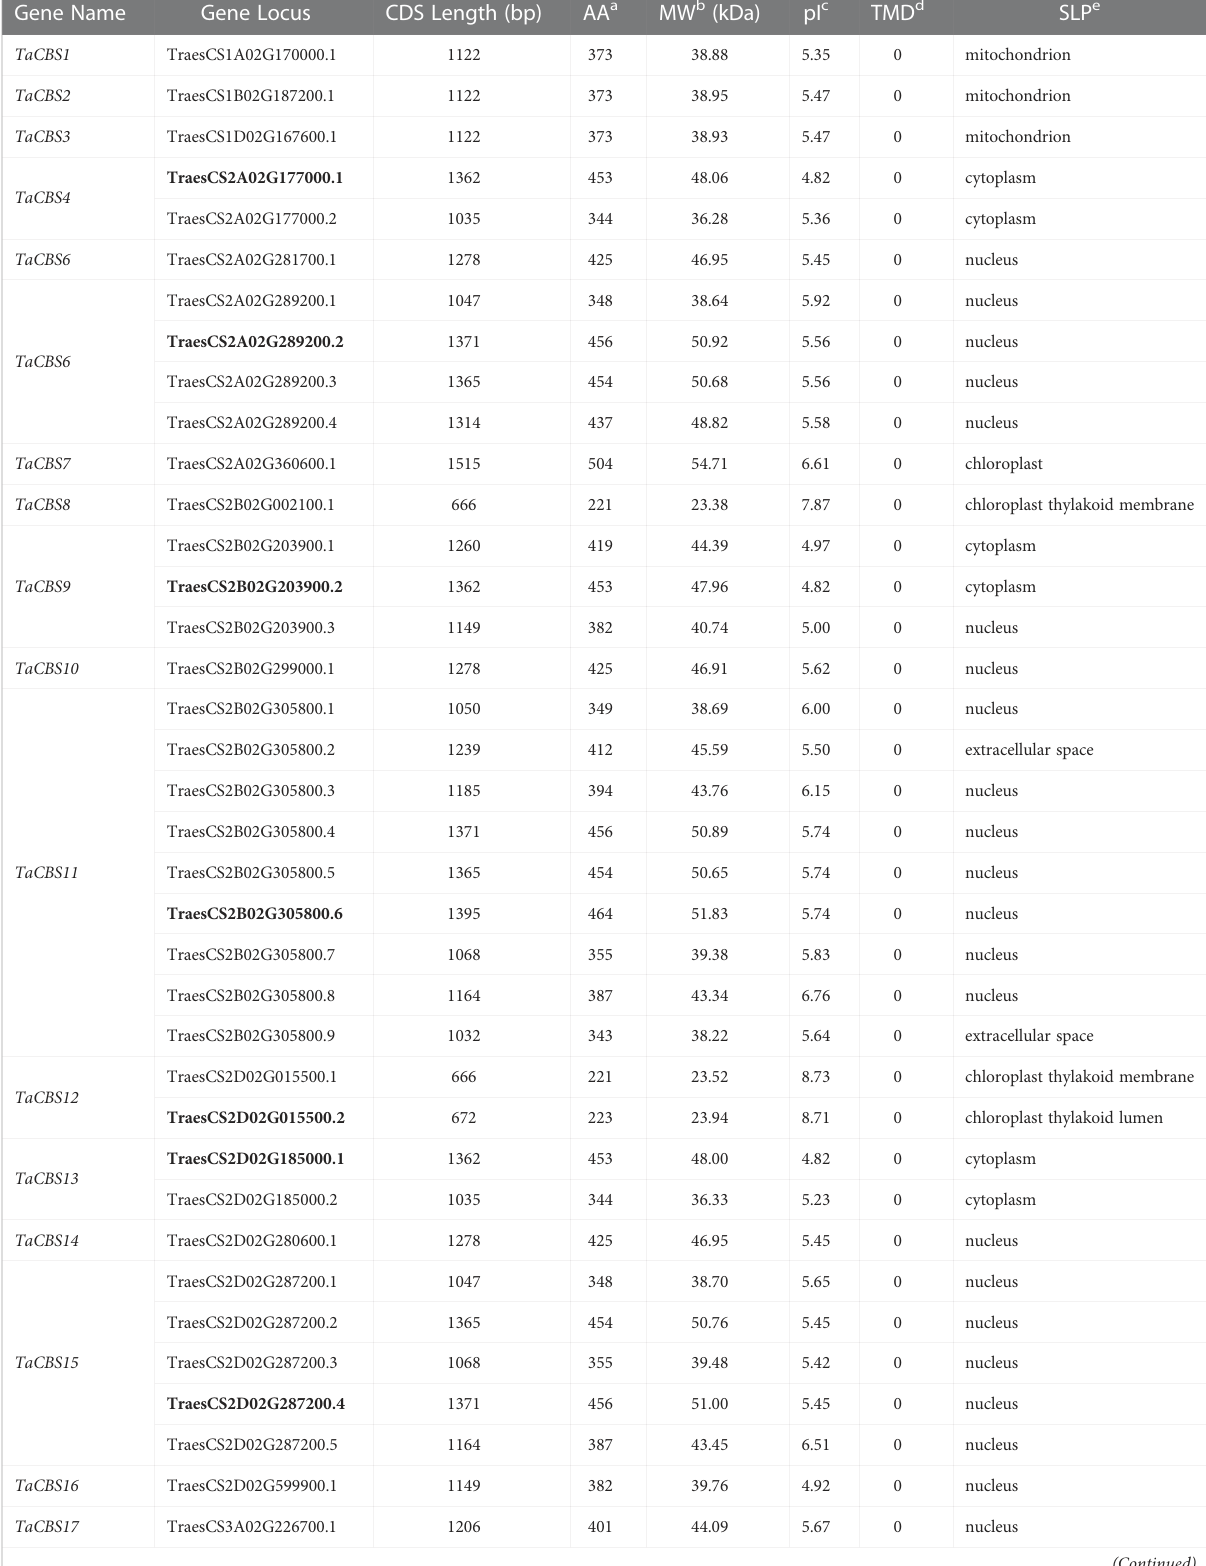
TABLE 1 Information about the TaCBS genes in